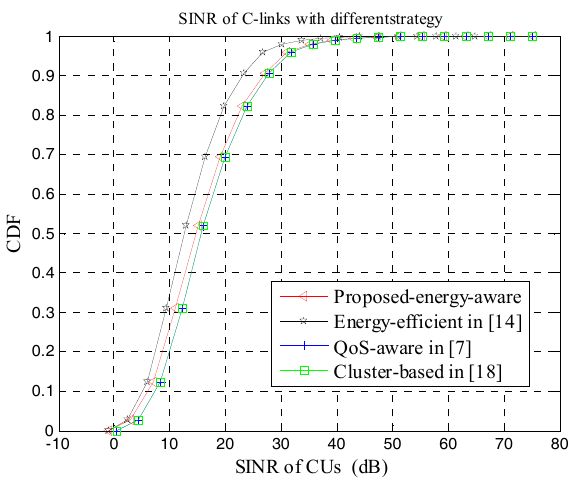
Figure 6. Signal-to-interference-and-noise ratio (SINR) of C-links with different schemes.